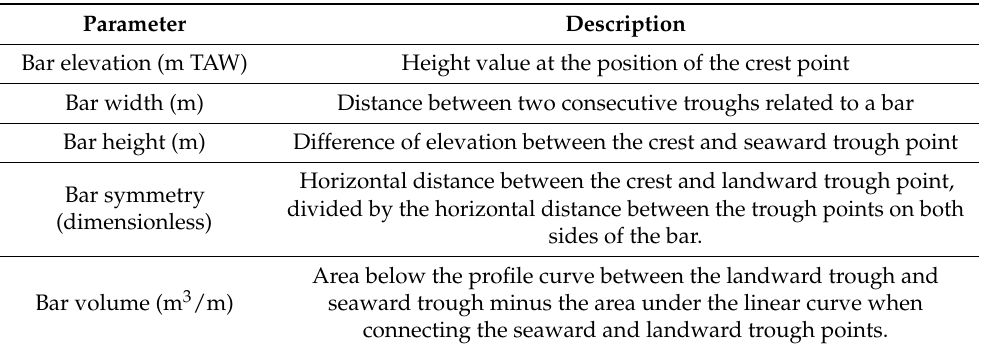
Table 1. Definition of parameters to characterize bar